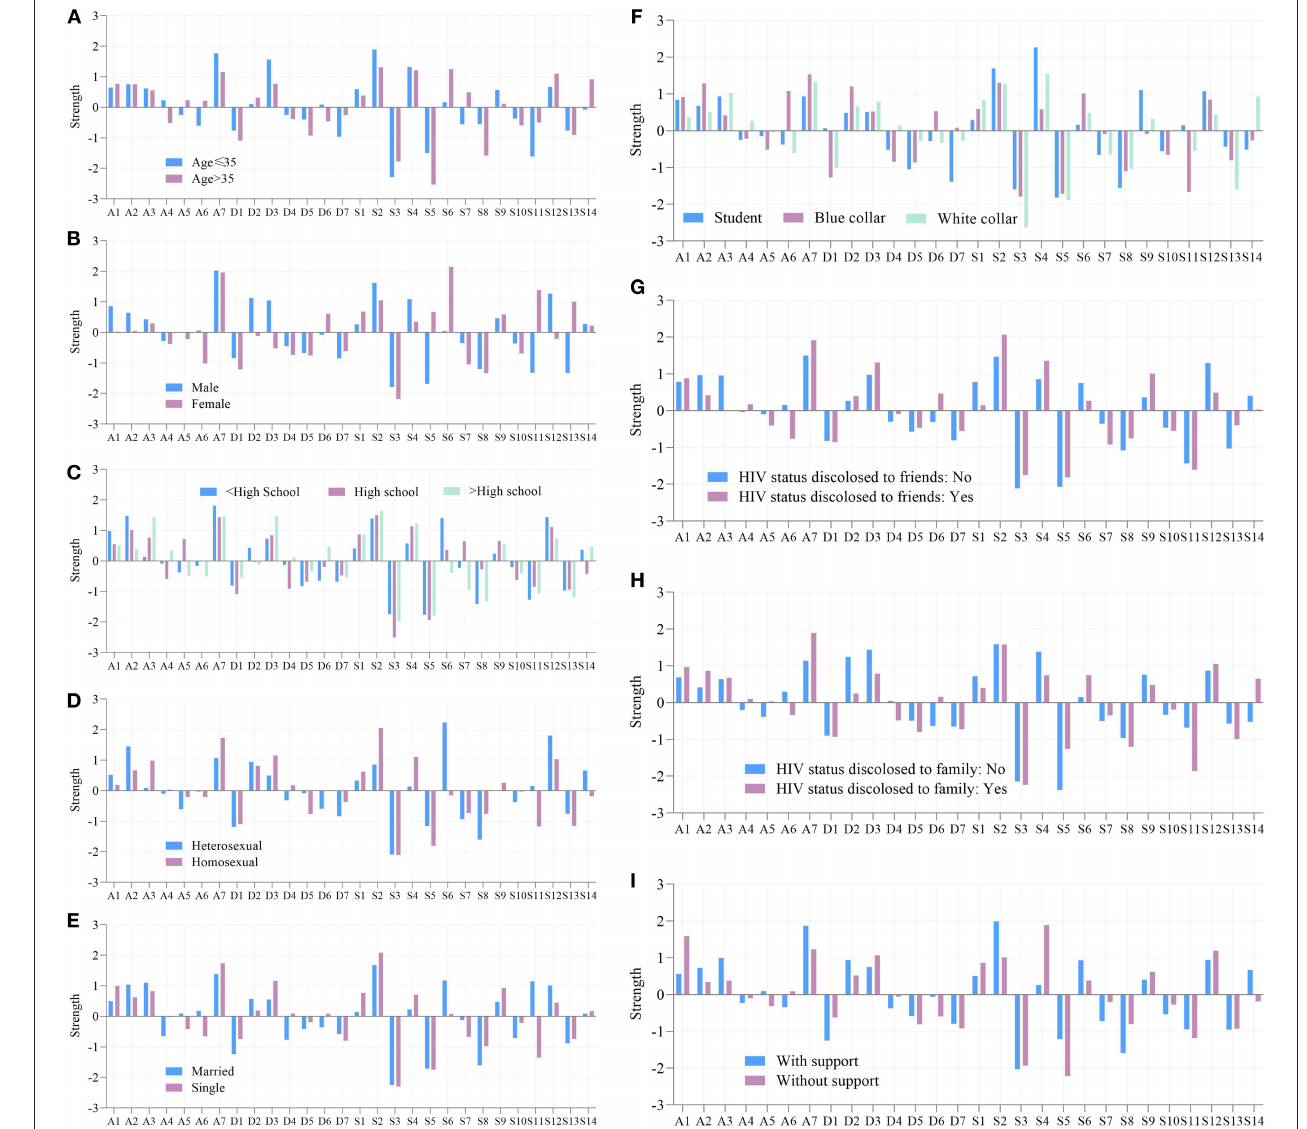
FIGURE 2 | Node centrality of each node in all subgroup networks. (A) Age. (B) Sex. (C) Education. (D) Transmission route. (E) Marital status. (F) Employment. (G) HIV status disclosed to friends. (H) HIV status disclosed to family. (I) Support from society/family. Strength are plotted using standardized z-scores in order to facilitate